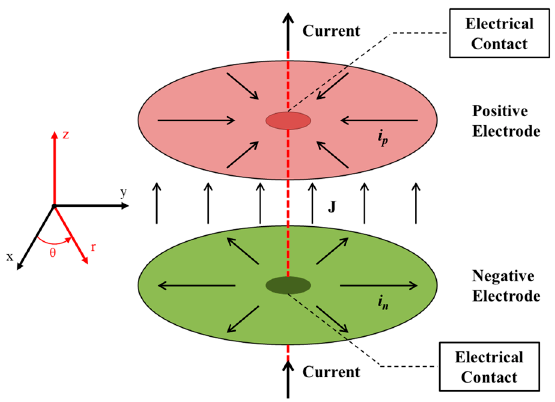
Figure 1. Schematic diagram of the currents in the two parallel circular electrodes during discharge.